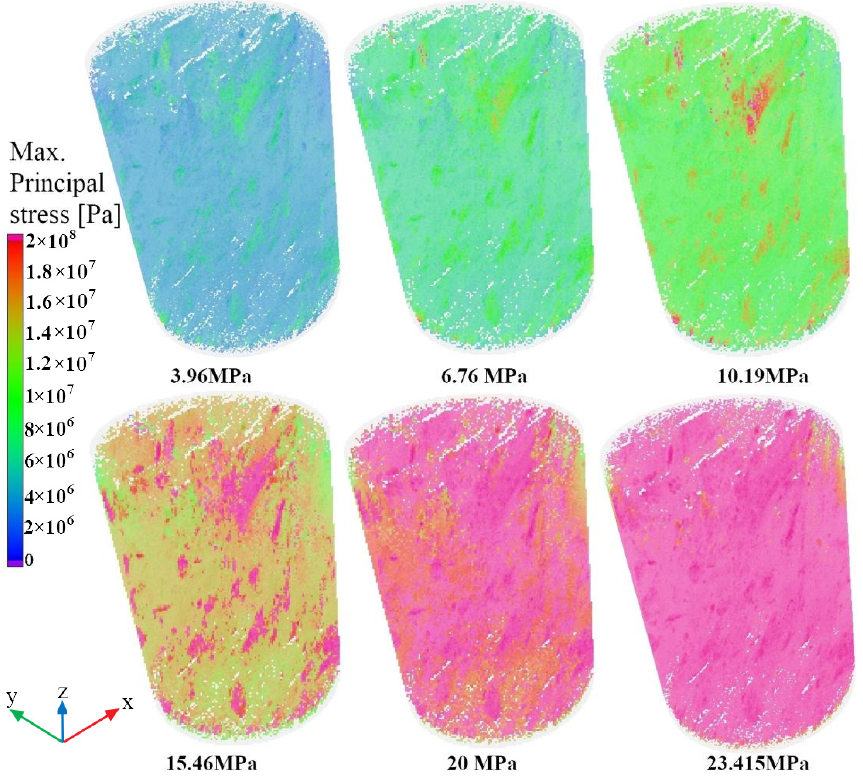
Figure 14. Simulated 3D shear stress field under different loads.